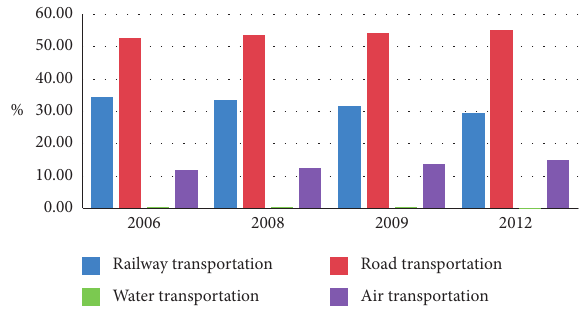
Figure 2: Passenger volume ratio for multiple